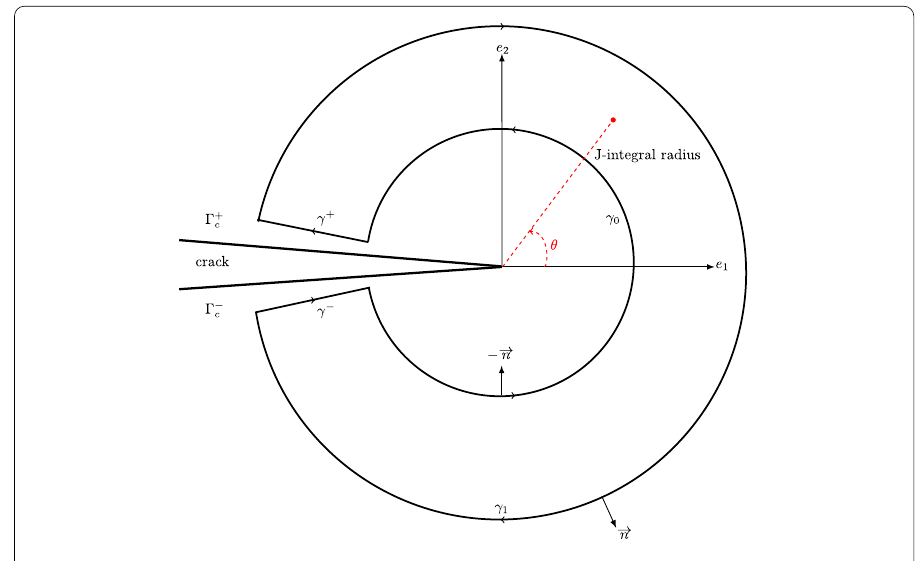
Fig. 3 Arbitrary J-integral area surrounding the crack